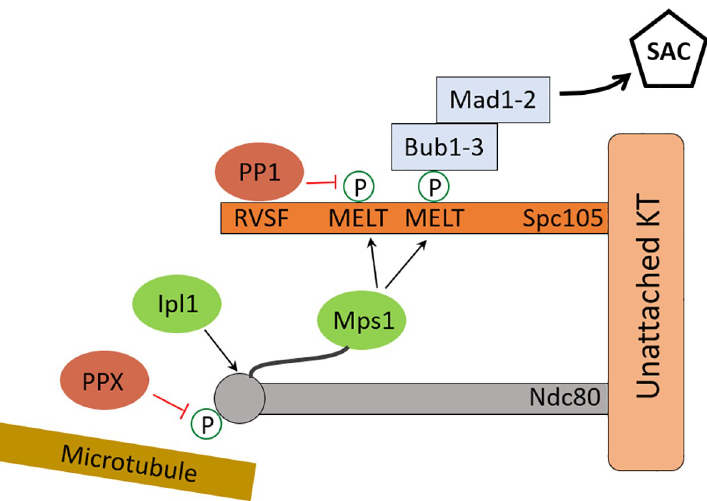
Fig 2. Scheme for kinase and phosphatase activities at the KT. Kinases are Ipl1 and Mps1 (shown in green), and phosphatases are PP1 and PPX (shown in red). Phosphorylation of MELT motifs by Mps1 starts the SAC signaling cascade and its dephosphorylation by RVSF-bound PP1 promotes silencing of the SAC signal. Phosphorylation of Ndc80 by Ipl1 weakens KT-MT attachment, and its dephosphorylation by PPX promotes KT-MT attachment.